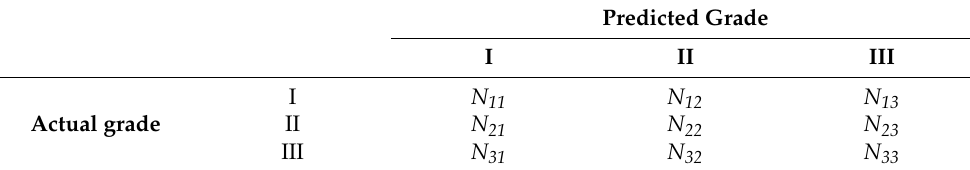
Table 4. Three-classification confusion